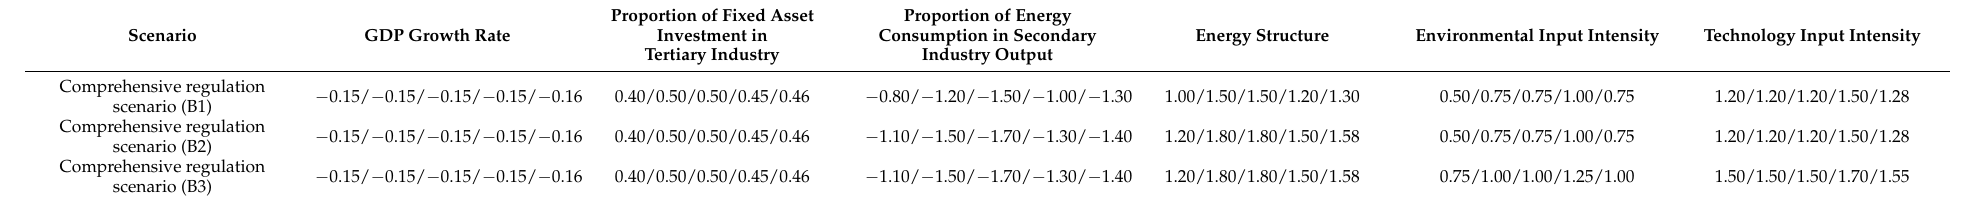
Table 9. Comprehensive regulation of carbon emissions scenario parameter setting